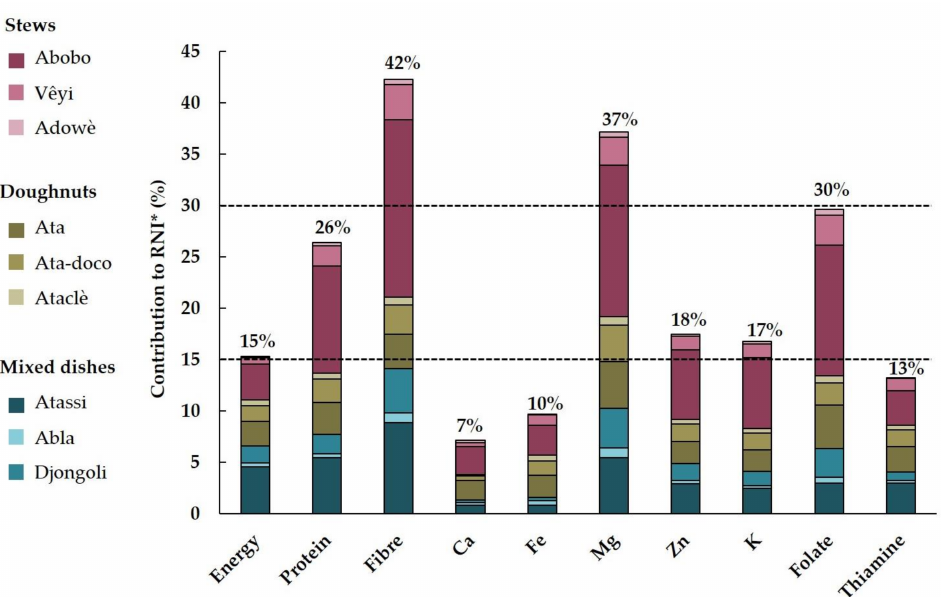
Figure 3. Mean total daily contribution to the RNI of the nine traditional cowpea-based dishes consumed during the week before the FFQ *. * All respondents, excluding non-consumers of cowpea seeds (i.e., 98% of respondents). Dotted lines show the thresholds to qualify a given food as source (15%) of, or as rich (30%) in protein, vitamins and minerals, as defined by the Codex Alimentarius